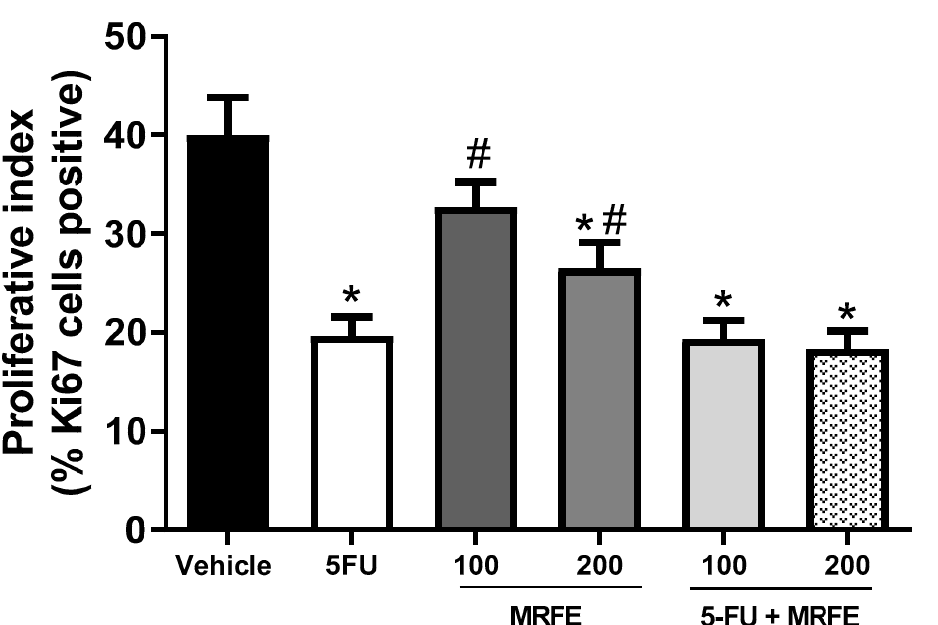
Figure 6. Quantitative analysis of Ki67 positive cells (nuclear immunostaining) representative of the estimation of the tumor proliferative index in the different experimental groups. Significant differences from the saline group were expressed as * p < 0.05, significant differences from the 5-FU group were expressed as # p < 0.05 (ANOVA and Bonferroni multiple comparison post test).